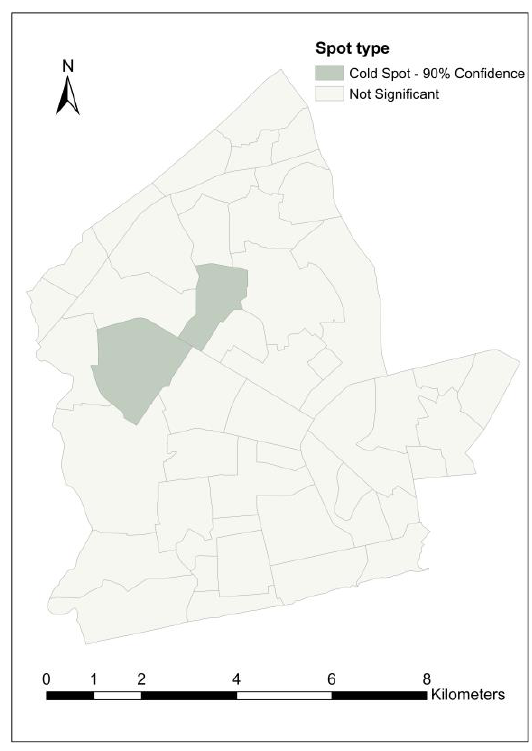
Figure 11. Cold spot neighborhoods for load shedding exposure per unit area.